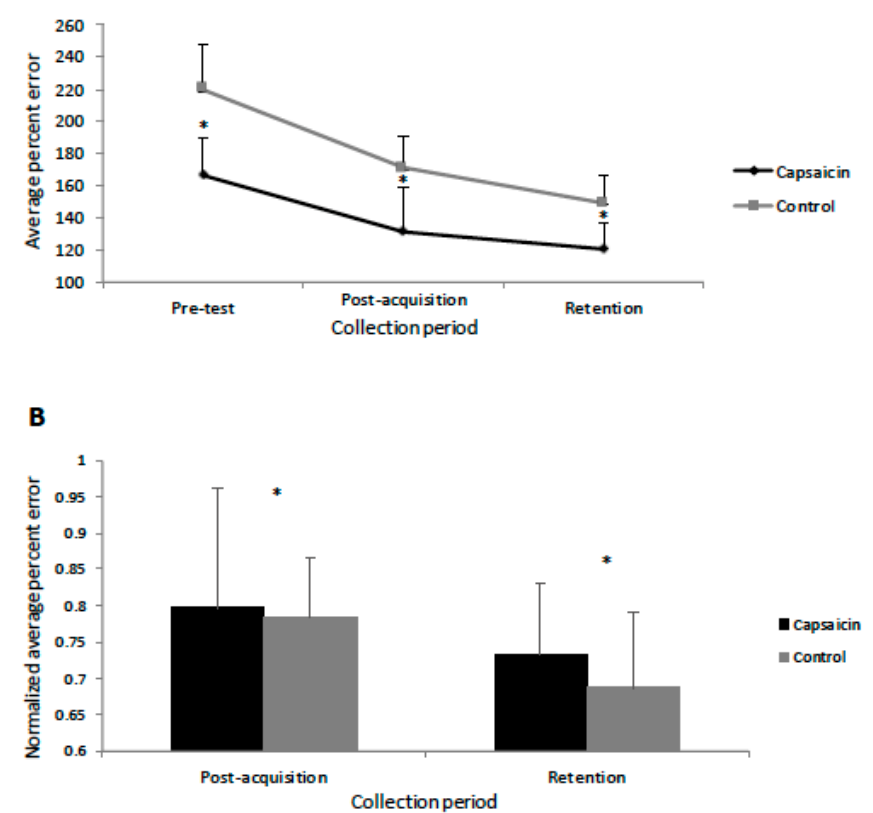
Figure 4. ( A ) Line-graph depicting the average percent motor error (in %) for the capsaicin and control groups. Significant differences between the groups are indicated by asterisks (all p < 0.005). Error bars represent the standard deviation. ( B ) Bar graph depicting the normalized percent error for the capsaicin and control groups. Significant differences (from pre-test) are indicated by asterisks (all p < 0.005) for both groups post-acquisition and at retention with no significant differences seen between the two